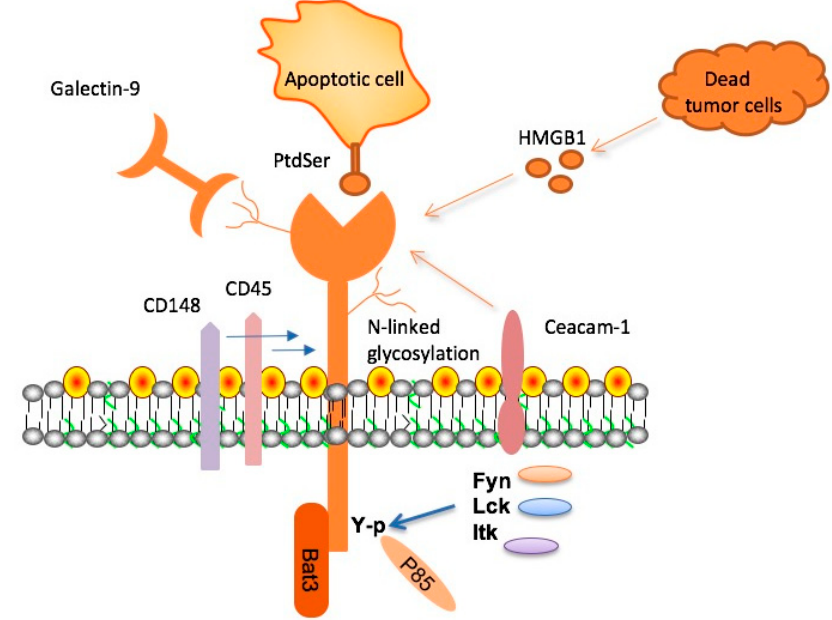
Figure 1. T cell immunoglobulin and mucin domain 3 (TIM-3), its ligands, and signaling adaptor proteins. Four ligands—namely, galectin-9 (Gal-9), phosphatidylserine (PtdSer), high mobility group protein B1 (HMGB1), and carcinoembryonic antigen cell adhesion molecule 1 (Ceacam-1)—have been identified to bind to the variable immunoglobulin (IgV) domain of TIM-3. In terms of signaling, HLA-B associated transcript 3 (Bat-3) binds to the cytoplasmic tail of TIM-3 and inhibits TIM-3 function. Fyn, Lck, and Itk, three tyrosine kinases, bind and phosphorylate specific tyrosine residues within the cytoplasmic domain of TIM-3. The phosphorylated tyrosines within the cytoplasmic domain of TIM-3 can recruit other downstream signaling adaptors such as p85 adaptor protein. In addition, Gal-9 can mediate the formation of clusters containing TIM-3, CD45, and CD148.